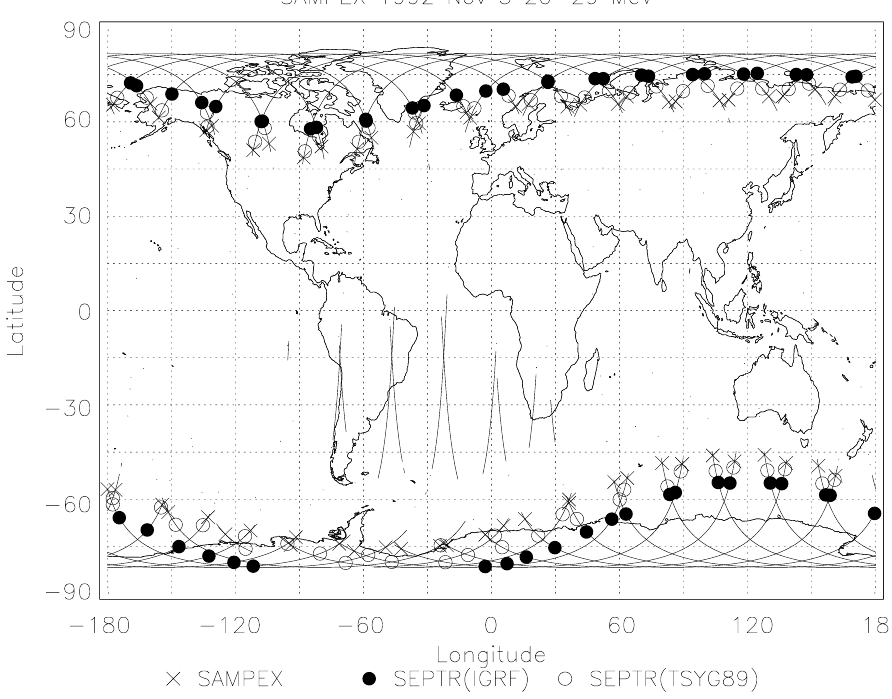
Fig. 1. The world grid for 3 November 1992 showing the observed PET 20–29MeV proton cutoffs (crosses), the calculated SEPTR Tsy- ganenko field cutoffs (open circles), and the calculated SEPTR IGRF field cutoffs (solid circles). High-latitude and SAA portions of the SAMPEX orbit are shown. In general, the IGRF cutoffs are poleward of the Tsyganenko cutoffs and further poleward of the PET